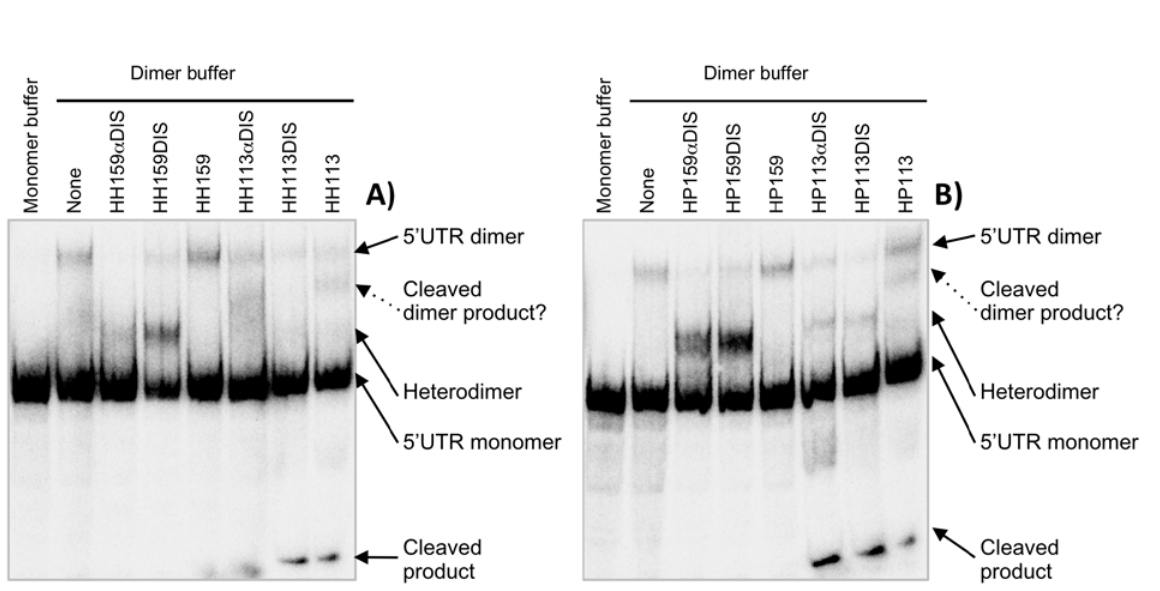
Figure 3. Inhibition of 5’UTR dimerization in vitro by chimeric inhibitor RNAs derived from both hammerhead and hairpin ribozymes [ A ) and B ), respectively). The 5’UTR dimerization was performed in the presence and absence of inhibitor RNAs. Dimerization reactions were carried out at 37 ºC for 20 min with 157 nmol of internally radiolabelled 5’UTR RNA and a 20-fold excess of inhibitory RNA. The reactions were resolved in 4% polyacrylamide native gels. Line 1 in both gels represents non-dimer condition controls. Line 2 represents 5’ UTR dimerization in the absence of any RNA inhibitor. The shifted band within line 2 with respect to line 1 is considered as the